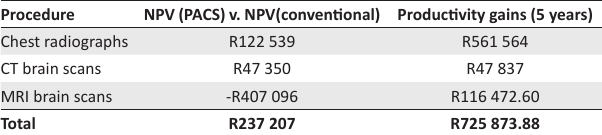
TABLE 8: Productivity gains after 5 years for chest X-rays and CT and MRI brain